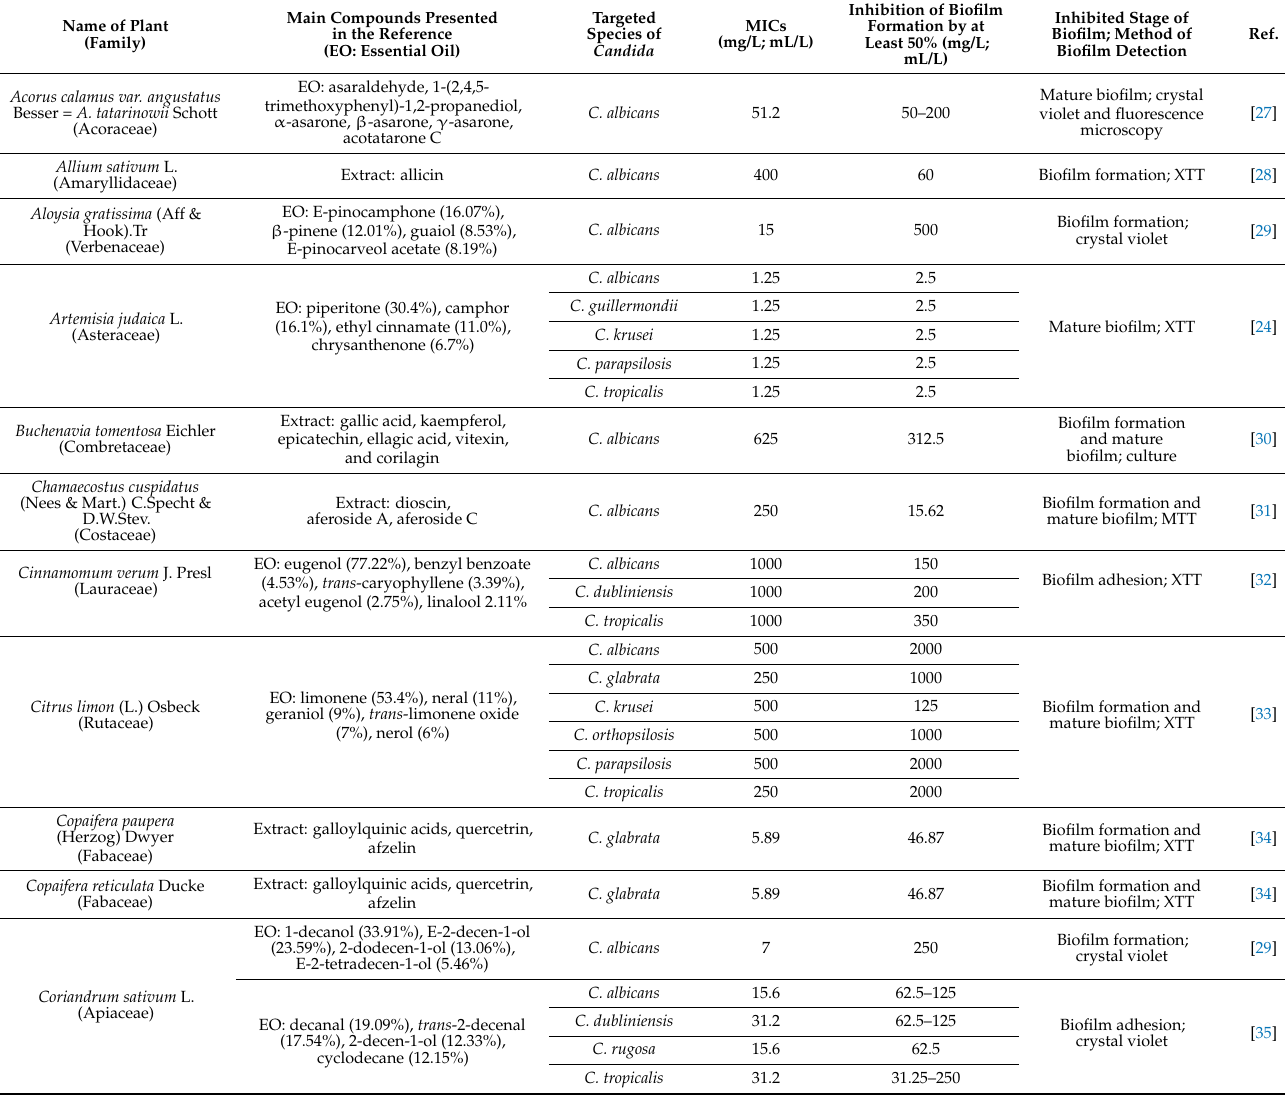
Table 1. Antifungal (MICs) and anti-biofilm (inhibition >50%) activity of plant preparations (essential oils or extracts). Name of Plant